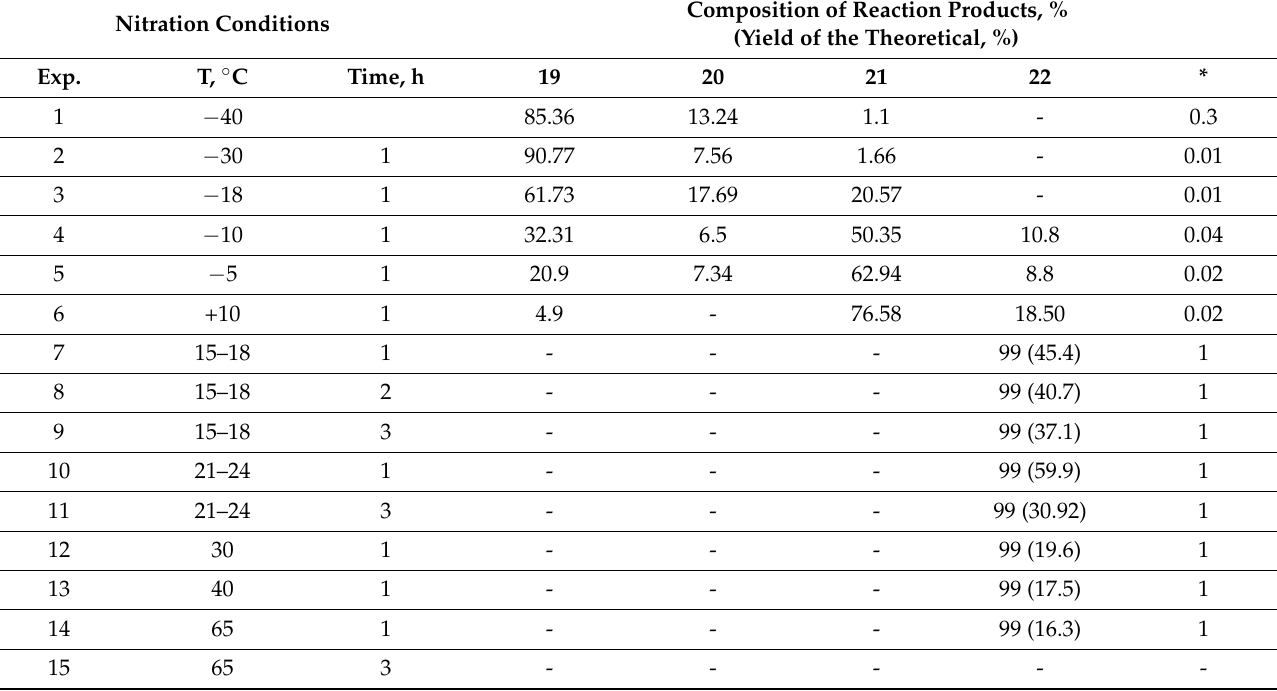
Table 3. Nitration of 19 with mixed